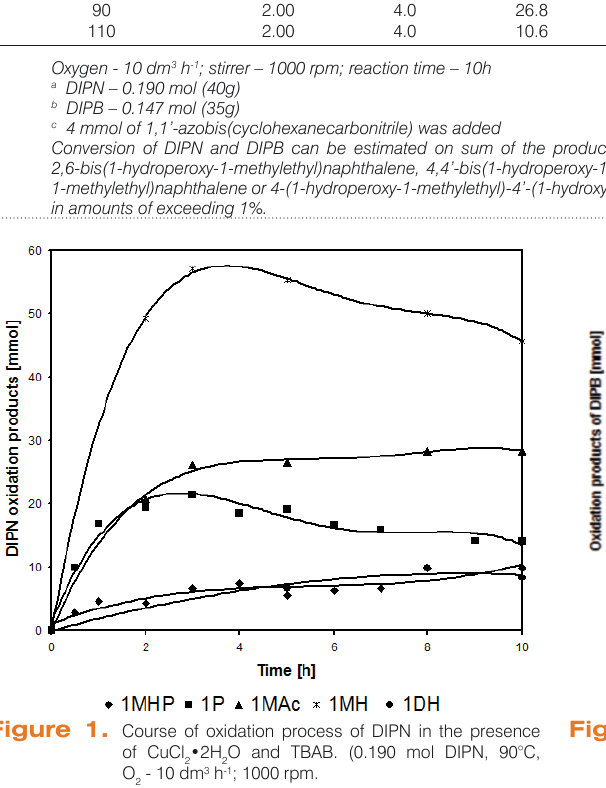
of CuCl •2H O and TBAB. (0.147 mol - DIPB, 90°C, 2 2 O - 10 dm 3 h -1 ; 1000 2